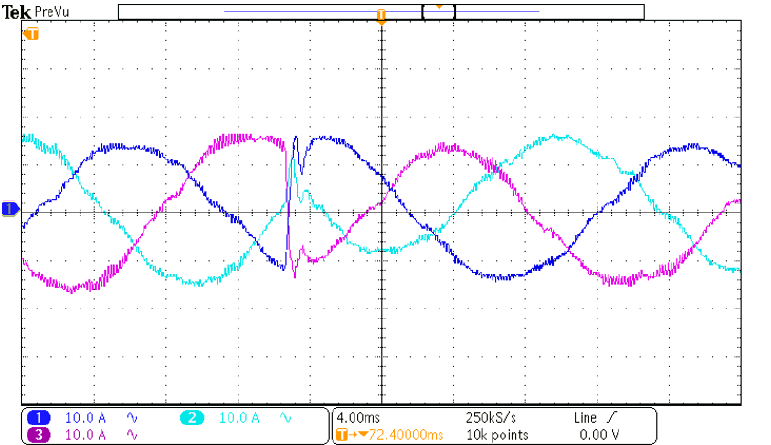
Figure 23. Experimental waveform of AHMMC current tracing channels 1, 2, 3 (10A